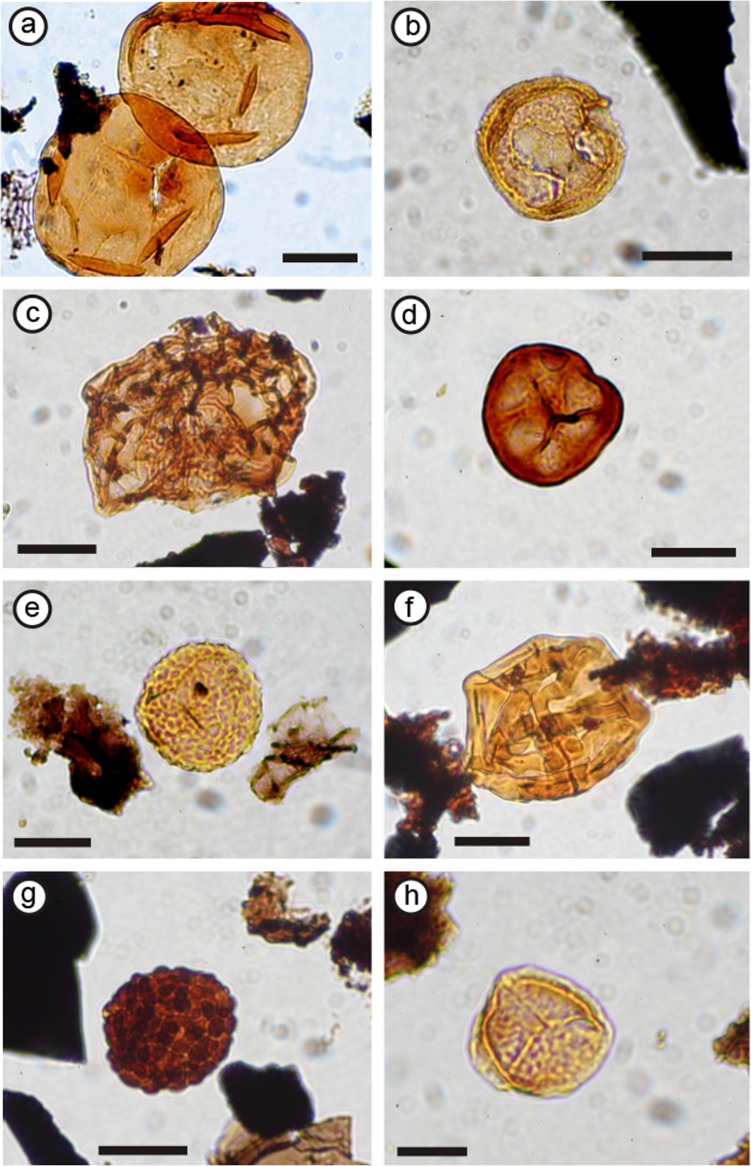
Representative specimens of miospore genera that dominate the microfossil assemblages at Loch Humphrey Burn.(1) Calamospora Schopf, Wilson & Bentall, 1944 (sphenopsid), specimen 206, horizon LH-2-15; scale bar = 25 µm. (2) Cyclogranisporites Potonié & Kremp, 1954 (filicopsid), specimen 151, horizon LH-4-9; scale bar = 20 µm. (3) Dictyotriletes (Naumova) Potonié & Kremp, 1954 (filicopsid), specimen 167, horizon LH-3-13; scale bar = 25 µm. (4) Knoxisporites (Potonié & Kremp) Neves 1961 (filicopsid), specimen 244, horizon LH-2-8; scale bar = 20 µm. (5) Microreticulatisporites (Knox) Bhardwaj, 1955 (filicopsid), specimen 146, horizon LH-2-15; scale bar = 20 µm. (6) Reticulatisporites Ibrahim 1933 (filicopsid), specimen 075, horizon LH-3-13; scale bar = 30 µm. (7) Verrucosisporites Ibrahim 1933 (filicopsid), specimen 047, horizon LH-2-5; scale bar = 20 µm. (8) Lycospora Schopf, Wilson & Bentall, 1944 (lycopsid), specimen 233, horizon LH-2-15; scale bar = 20 µm.